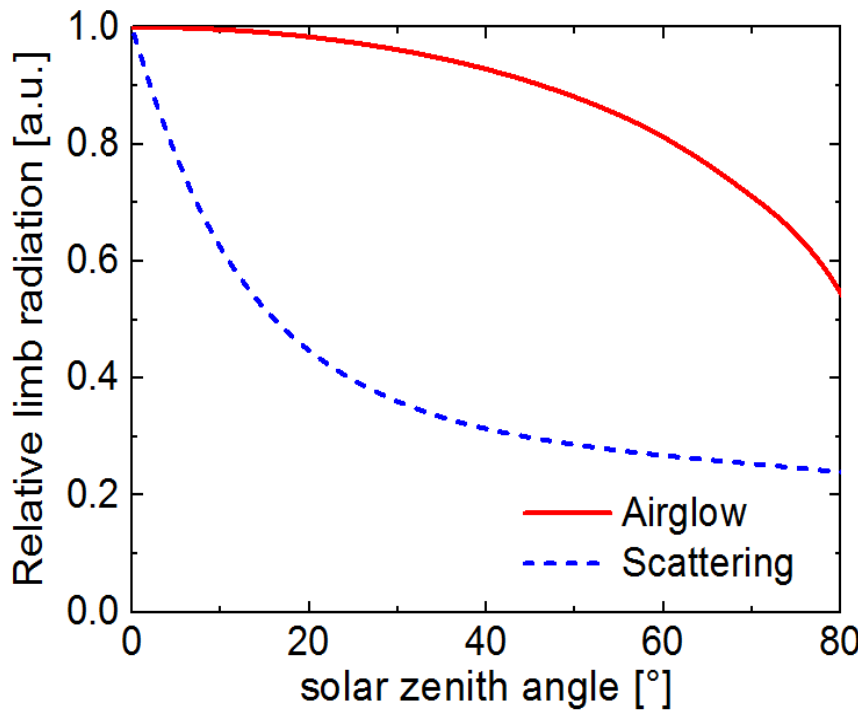
Figure 15. The relative limb radiation of both the airglow emission and atmospheric scattering varying with the SZA for a tangent height at 40 km.